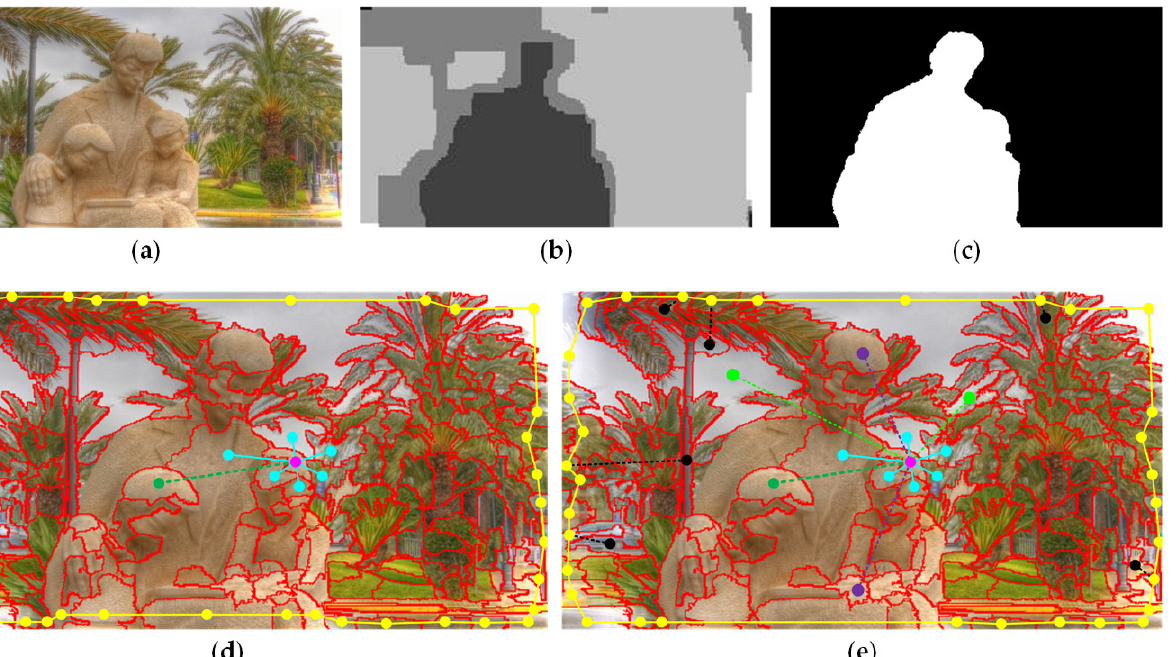
Figure 5. Visual comparisons of different graph-based results. ( a ) Original RGB images. ( b ) Original depth images. ( c ) Saliency maps produced by two-graph neighborhood graph. ( d ) Saliency maps produced by two-layer sparse graph. ( e ) Saliency maps produced by improved two-layer sparse graph based on background seed screening mechanism (BSSM). ( f ) Saliency maps produced by improved two-layer sparse graph without the non-local connections. ( g ) Saliency maps produced by improved two-layer sparse graph with the non-local connections. ( h ) Ground truth. 2.3.3. Cross-Modal Multi-Graph Learning Model The two-layer sparse graph constructs the connections among the local regions, which will restrict the range of random walk to the local regions. Therefore, the absorption time may be inaccurate, especially when the long-range smooth background distributes